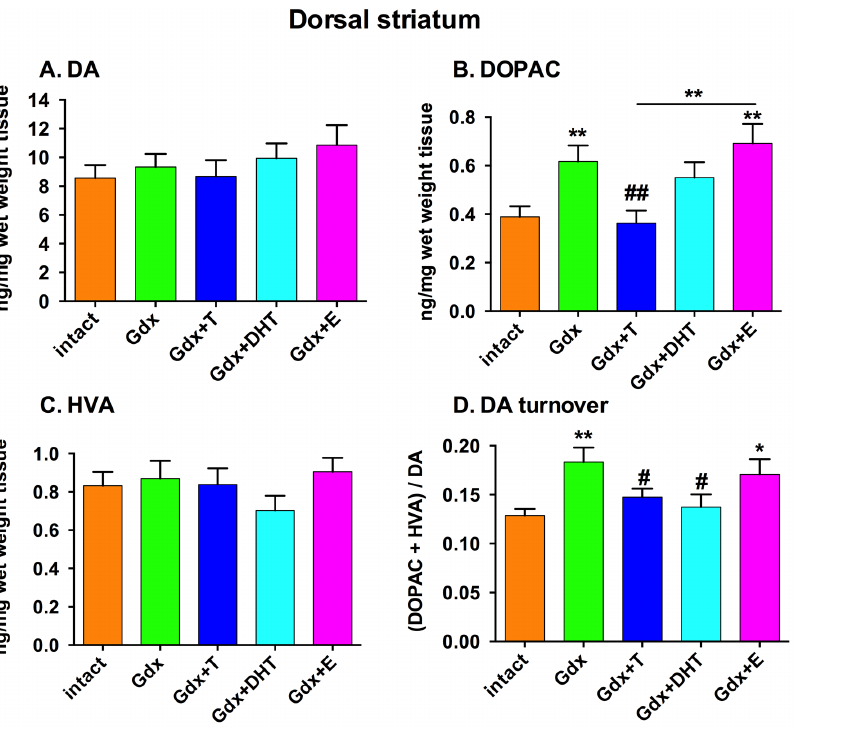
Figure 5. The effect of gonadectomy and sex steroid replacement on dopamine, dopamine metabolites and dopamine turnover in the dorsal striatum of adolescent male rats. There was no significant effect of treatment group on dopamine (A) or HVA (C) . Gonadectomy increased DOPAC (B) and this increase was attenuated by testosterone replacement only. Dopamine turnover (D) was significantly increased by gonadectomy and this was attenuated by testosterone and DHT replacement but not 17 b -estradiol replacement. * denotes comparison with Intact unless comparison indicated by a line, # denotes comparison with the Gdx group, * and # p , 0.05; ** and ## p , 0.01, n=11–16/group for all. doi:10.1371/journal.pone.0091151.g005 Table 2. Summary of gene expression and protein changes in response to sex steroid replacement relative to the Gdx group.